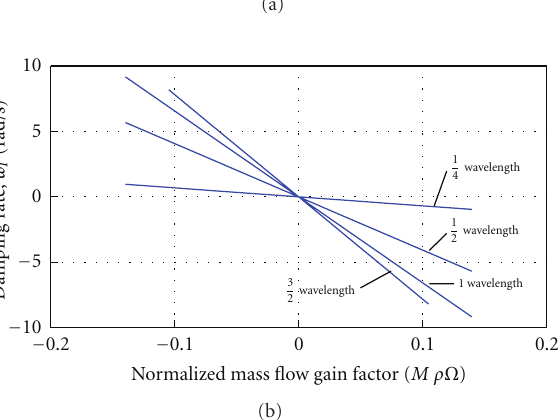
Figure 5: Acoustic mode in a feed pipe with decrease of cavitation number ( σ ).